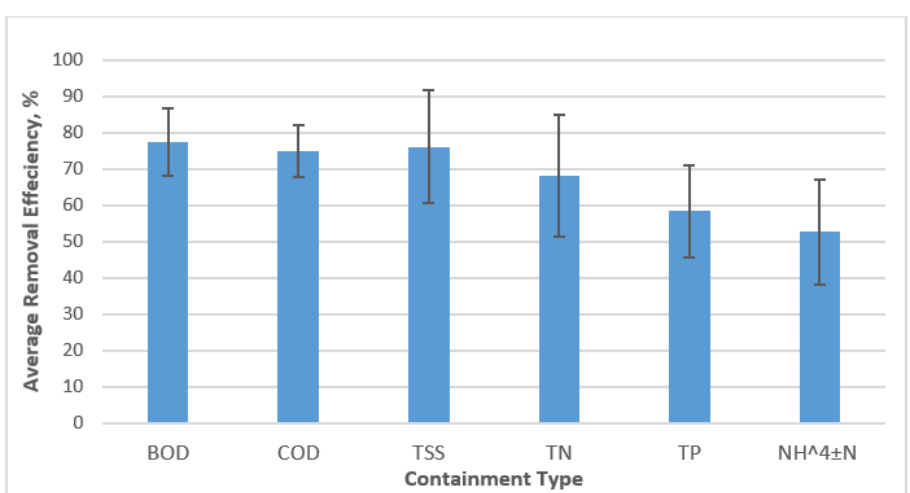
Figure 4. Horizontal flow site systems removal efficiency.